Question: Write a descriptive caption for this figure.
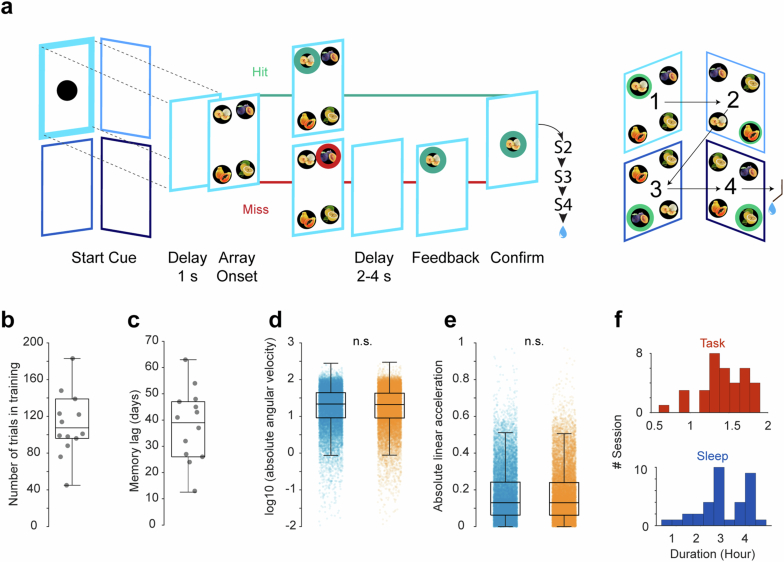
Answer: Experimental design and neural population analysis methods. a , Left: 3D rendering of the Treehouse 3D task environment indicating the opposite corners where old and new visual stimulus arrays are presented sequentially on touch screens. Right: trial schematic illustrating an example item-context sequence across four screens, with the correct target items circled in green. Item positions on the screens are randomized across screens and trials. Old and new item-context sequences (corners) are visited in alternating blocks 27 ( Methods ). b , Target selection rates per sequence condition. The center circle shows the median accuracy across sets, the box shows the interquartile range and the whiskers show the most extreme nonoutlier values. Performance of new sequences improved between the first and second days of presentation (permutation test with FDR correction; P < 0.001), and performance of old sequences exceeded newly presented sequences (versus new on day 1; permutation test with FDR correction P < 0.001 versus recent on day 2; permutation test with FDR correction; P < 0.05), trial category label permutation tests). * P < 0.05, *** P < 0.001. c , Left: computed tomography (CT)–magnetic resonance imaging (MRI) reconstructed electrode trajectories for monkey 1 (black) and monkey 2 (gray) projected onto a macaque template brain 76 , with representative spike waveforms shown across adjacent recording channels from the high-density deep arrays. Right: isolated single-unit yields across sessions (monkey 1: n = 17 sessions; monkey 2: n = 18 sessions). The center circle shows the median number of isolated units across sessions, the box shows the interquartile range and the whiskers show the most extreme nonoutlier values. d , Top: timing of trial events across a sequence of four screens for two old trials. Middle: movement trace, shown as the vector norm of angular velocity. Bottom: raster plots of corresponding population spiking activity (time × cells), sorted accordin